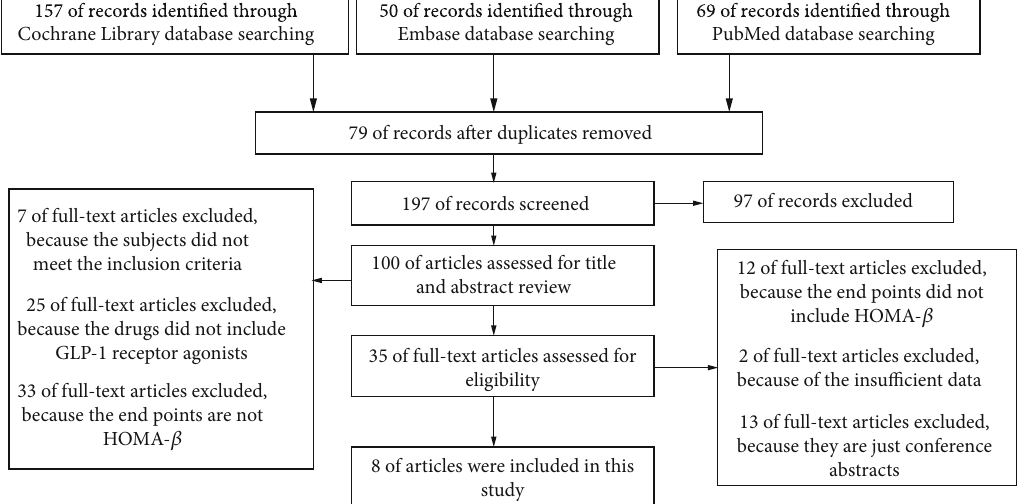
Figure 1: Selection of the articles included in this